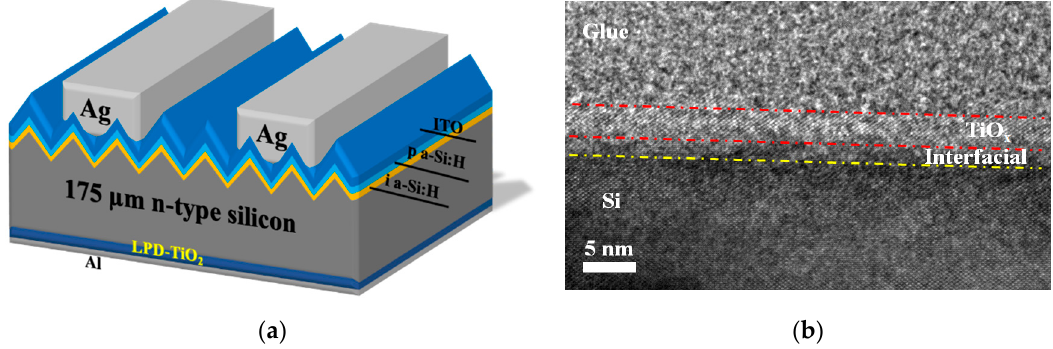
Figure 1. ( a )The schematic diagram of the fabricated heterojunction solar cell that exhibits an LPD- grown interfacial layer between Al and Si at its rear surface. ( b ) TEM images of thin TiO x layer on the Si surface. The sample TiO x layer was grown uniformly on the Si surface.